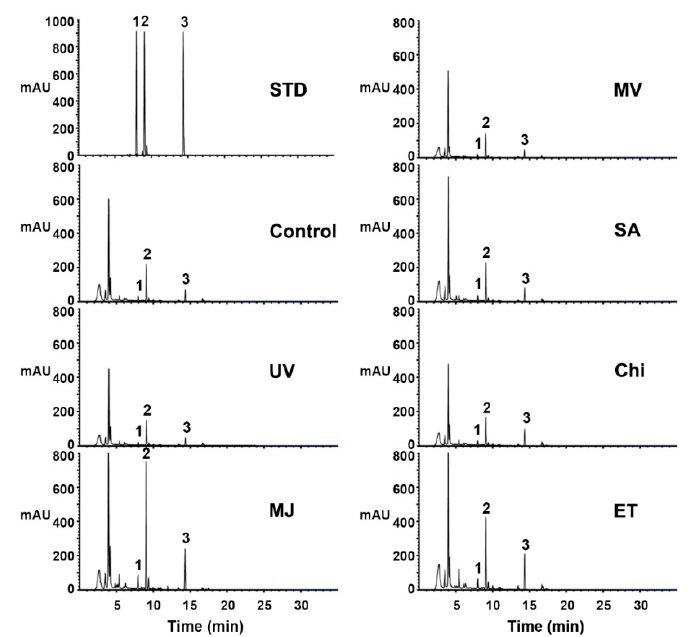
Figure 3. Effects of various elicitors on the production of pterocarpans (maackiain, trifolirhizin, and trifolirhizin malonate) in the S. flavescens cell cultures. Cells were pre-cultured for seven days and harvested three days after elicitation with the indicated elicitors. Samples were extracted with methanol and analyzed by HPLC. The elicitors used are as follows: UV, ultraviolet ray; MJ, methyl jasmonate; MV, methyl viologen; SA, salicylic acid; Chi, chitosan; ET, ethephon. Cells treated with 0.1% ethanol was used as a control. Chromatogram STD represents the authentic standards 1 (trifolirhizin), 2 (trifolirhizin malonate), and 3 (maackiain), with retention times of 7.88, 8.93, and 14.28 min, respectively.